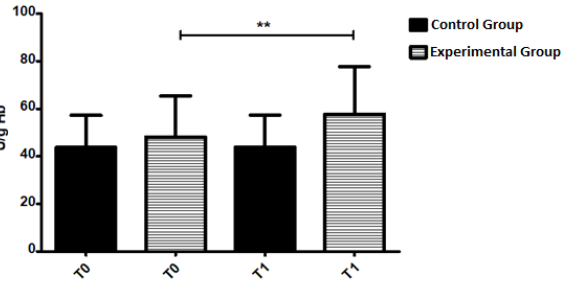
Figure 1. Glutathione Peroxidase activity at T0 and T1 of control and experimental groups. The results are expressed as U/g Hb and as mean ± standard deviation. ** p < 0.005.